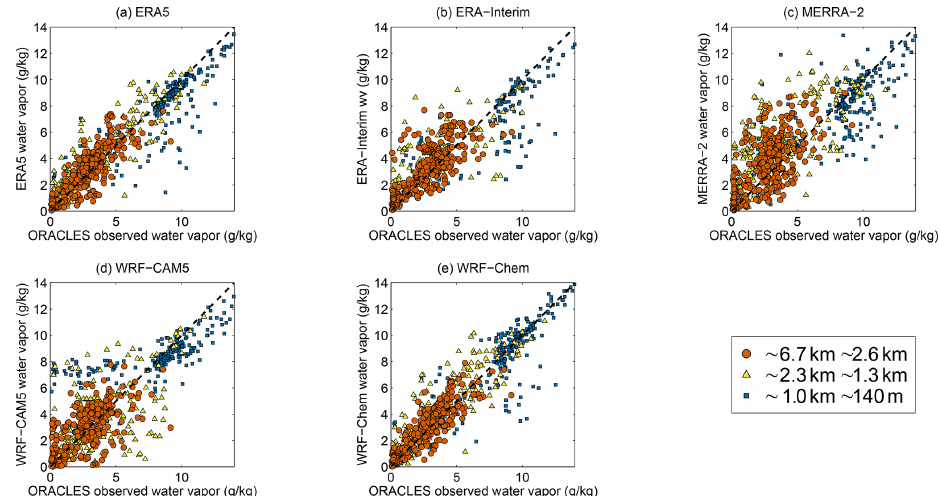
Figure 6. ORACLES water vapor measurements compared with reanalyses and models subset to the locations of aircraft profiles and altitudes of ERA5 outputs. Observations are averaged within ± 50m of the reanalysis levels; MERRA-2 reanalysis is averaged over the time of the aircraft profile and interpolated to ERA5 altitudes for ease of comparison. Free tropospheric altitudes are shown by circles; smaller squares are the boundary layer, and triangles are intermediate altitudes. Here we see that (a) the ERA5 water vapor and the observed water vapor subset to ERA5 altitudes show good agreement within the plume layer and for the lower boundary layer ( R 2 = 0 . 79 for z > 2km); agreement is poorer for (b) ERA-Interim ( R 2 = 0 . 53), (c) MERRA-2 ( R 2 = 0 . 40), and (d) WRF-CAM5 ( R 2 = 0 . 48), although a linear CO– q relationship is still seen. (e) WRF-Chem initialized from ERA5 shows better agreement ( R 2 = 0 . 79).